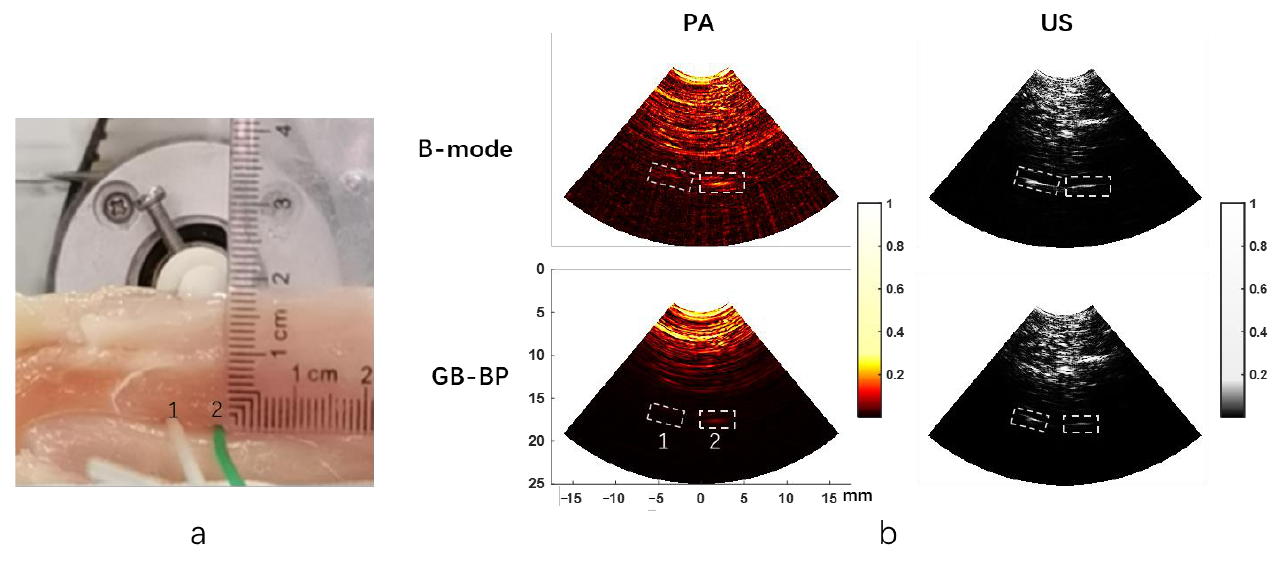
Figure 6. ( a ) The picture of chicken breast phantom experiments; ( b ) The photoacoustic and ultrasonic images reconstructed by two algorithms when the PVC tube is placed 18 mm deep below the surface of the chicken breast tissue. Two white dashed boxes contain two PVC tubes, and right tube 2 contains the ICG. Coordinate axis units are millimeters. Table 1. The calculated SNRs of two targets with different reconstruction algorithms.